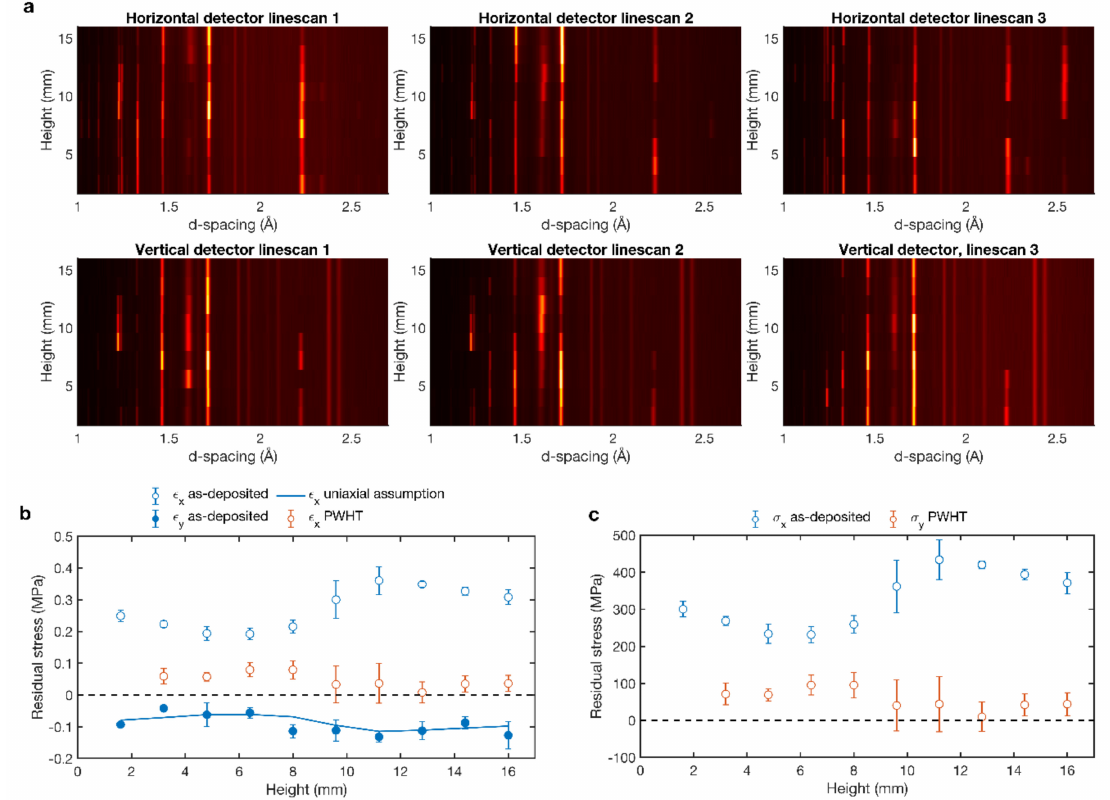
Figure 8. ( a ) 2D plot di ff raction spectra of the as-deposited condition, for the horizontal and vertical detectors as a function of height in the wall. ( b ) Residual strains and ( c ) residual stresses for as-deposited and PWHT conditions as a function of height in the single